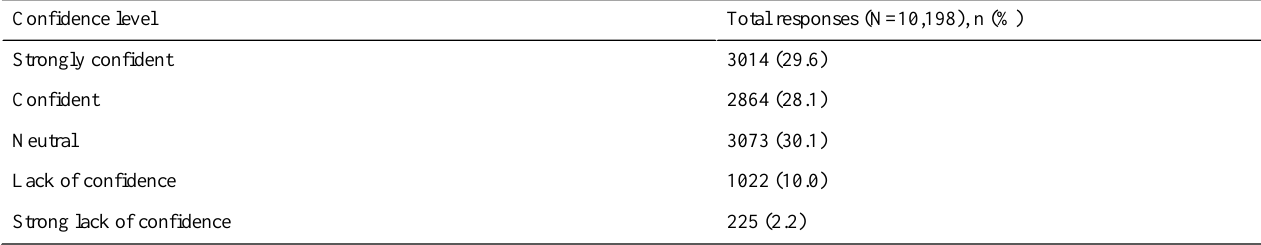
Table 5. Participants’confidence in curbing the COVID-19 epidemic in